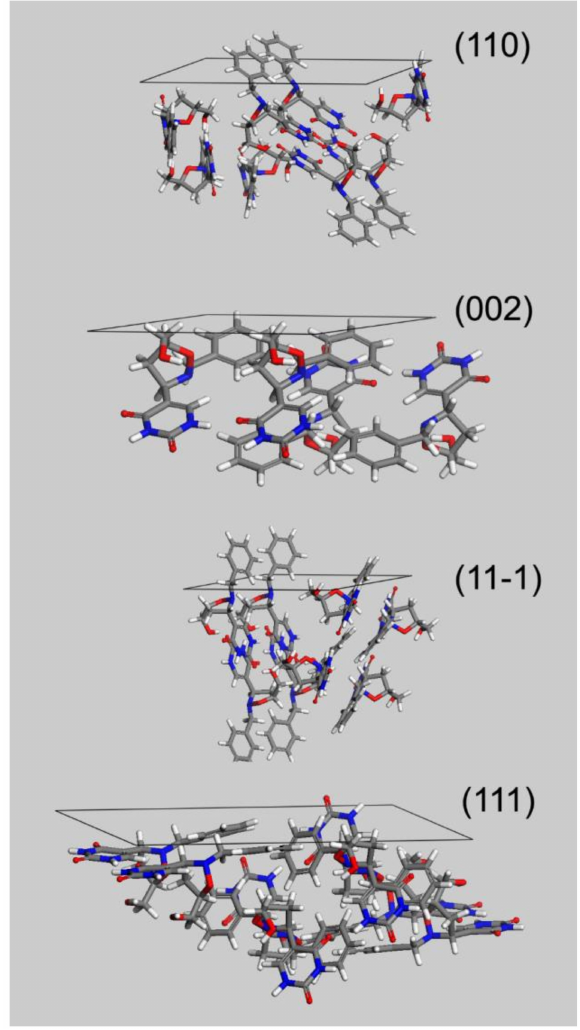
Figure 5. MI faces, and their corresponding Miller indices, for 3